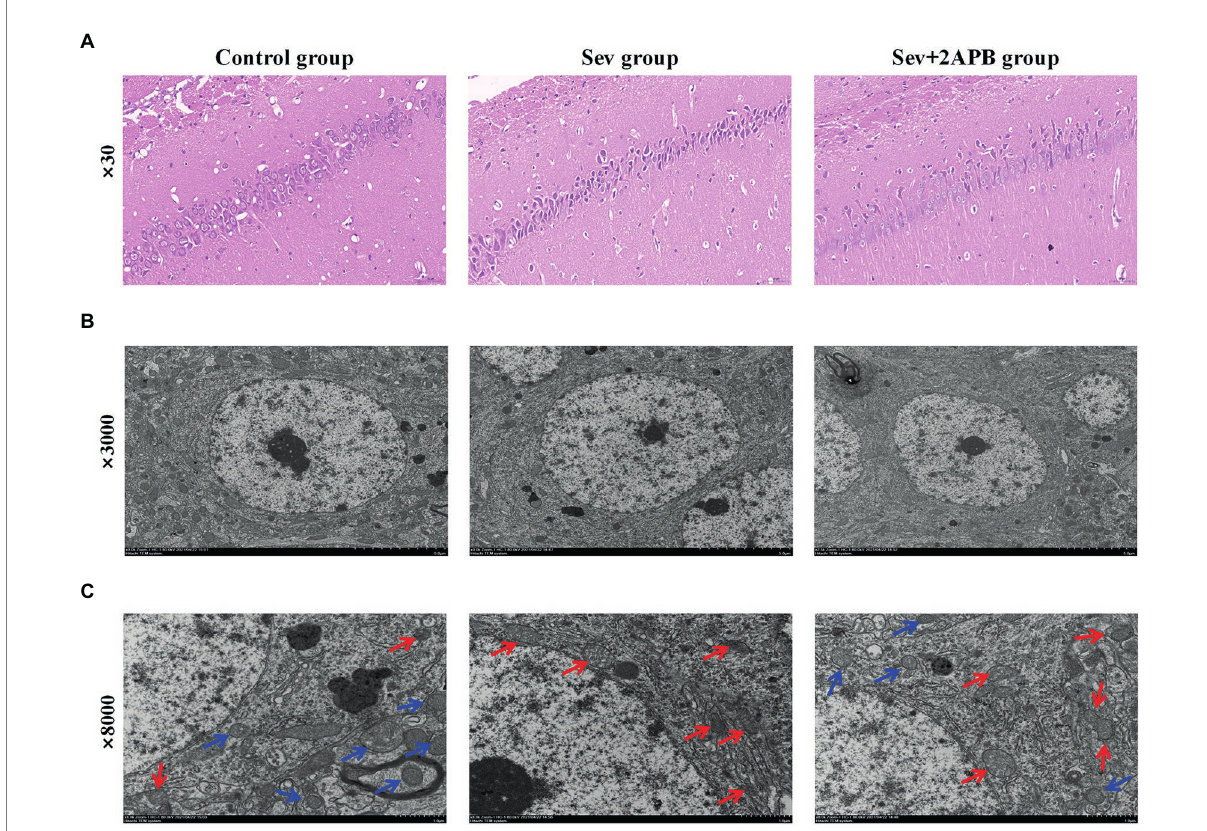
FIGURE 5 Sevoflurane promotes neuronal injury in aged rats. (A) Representative images of histopathological changes in the hippocampal CA1 region of aged rats (× 30). ( B) Representative images of hippocampal neurons in the CA1 region under the transmission electron microscope (× 3,000). (C) Representative images of hippocampal neurons in the CA1 region under the transmission electron microscope (× 8,000). n = 5 in each